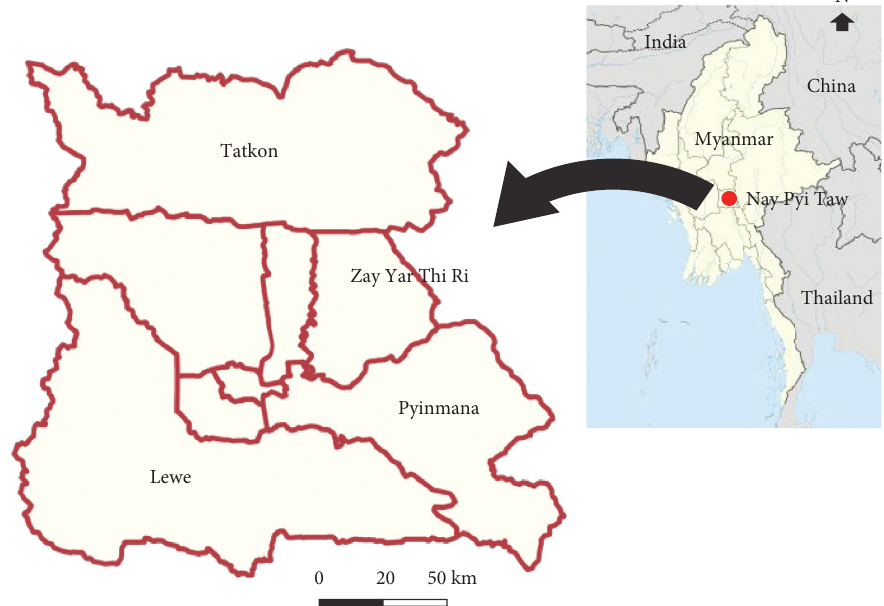
Figure 1: Map of the sampling